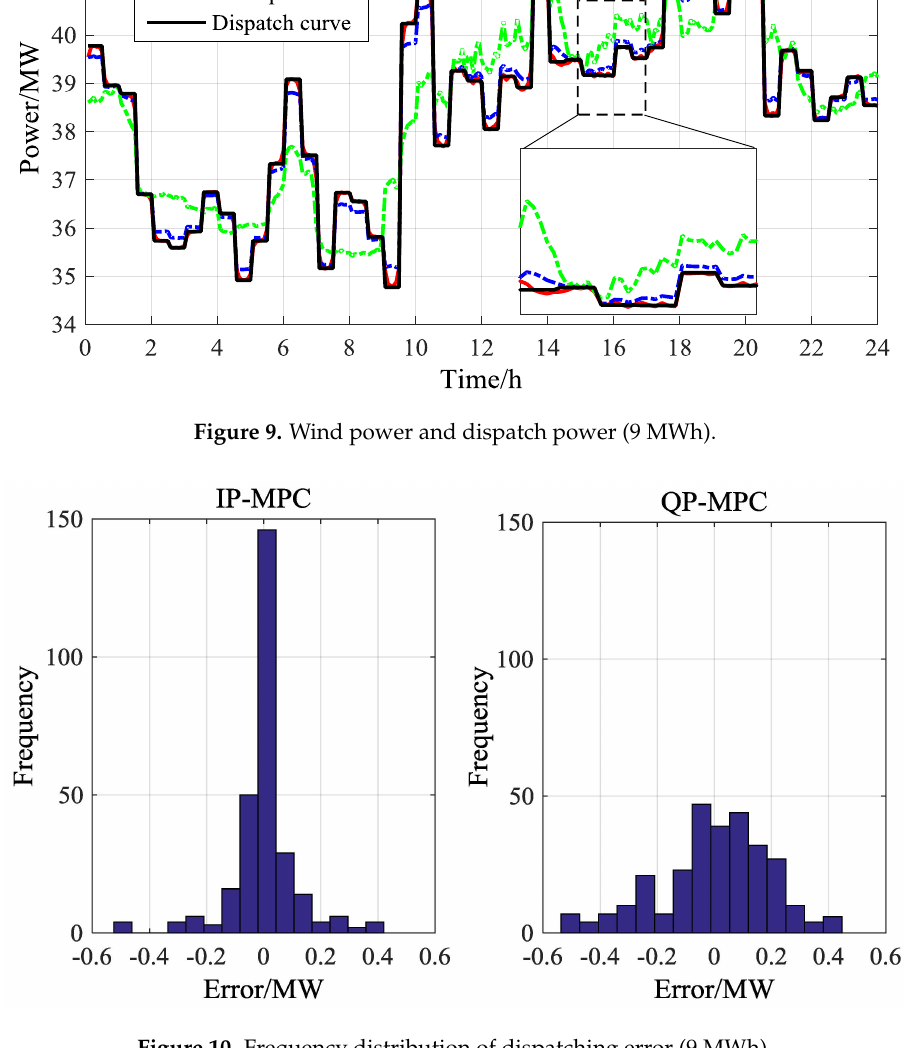
Figure 10. Frequency distribution of dispatching error (9 MWh). Table 2. Statistic result of dispatching error (9 MWh).